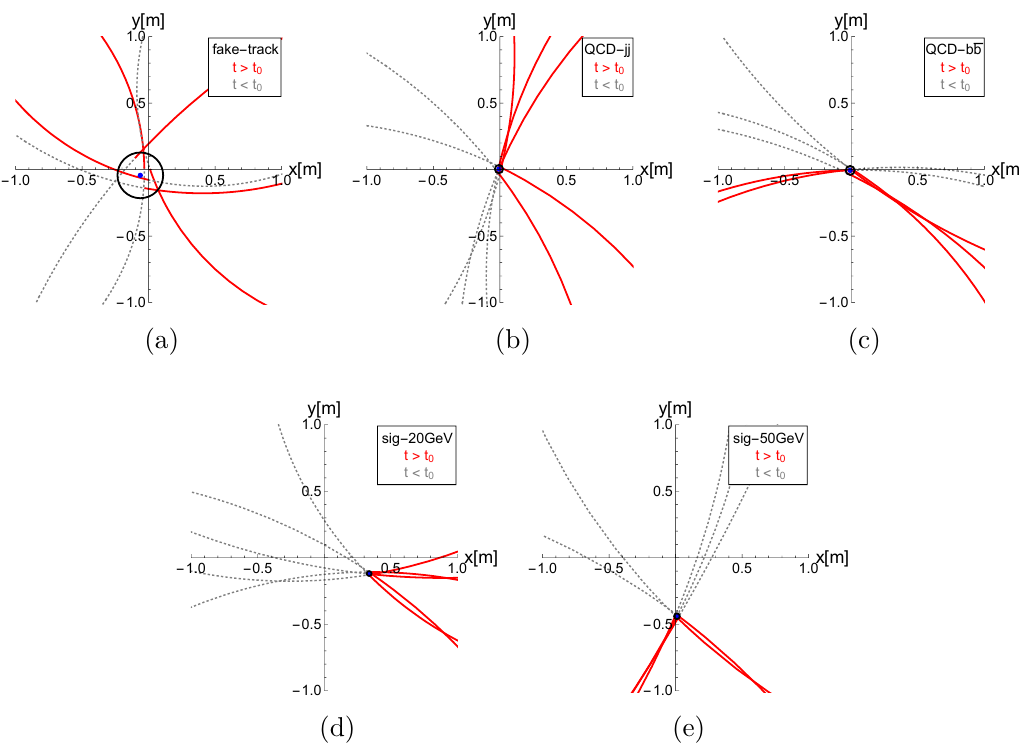
Figure 4 . Illustrative event displays in the x – y plane for the fitting algorithm with leading five displaced tracks. The blue dot is the fitted DV. The solid red (dashed gray) lines are the charged track trajectories in the event, after (before) the fitted DV. From left to right, the plots are for (a) fake-track background, (b) SM QCD light jet background, (c) SM QCD heavy-flavor jet background, (d) LLP signal with m X = 20 GeV and (e) LLP signal with m X = 50